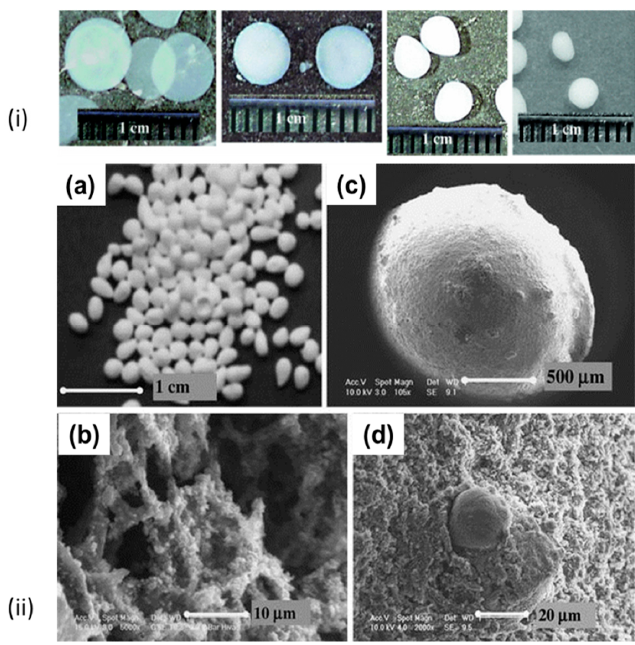
Figure 10. Wet and dry (aerogels) cellulose particles: ( i ) top row—the photographic images of wet cellulose particles (coagulated cellulose in water) of various shapes and ( ii ) bottom row—photographic image of TiO 2 -encapsulated cellulose aerogel ( a ), its morphology by SEM ( b ) and SEM images of the morphology of iron-encapsulated cellulose aerogel particles ( c , d ); reproduced with permission from reference[142] .